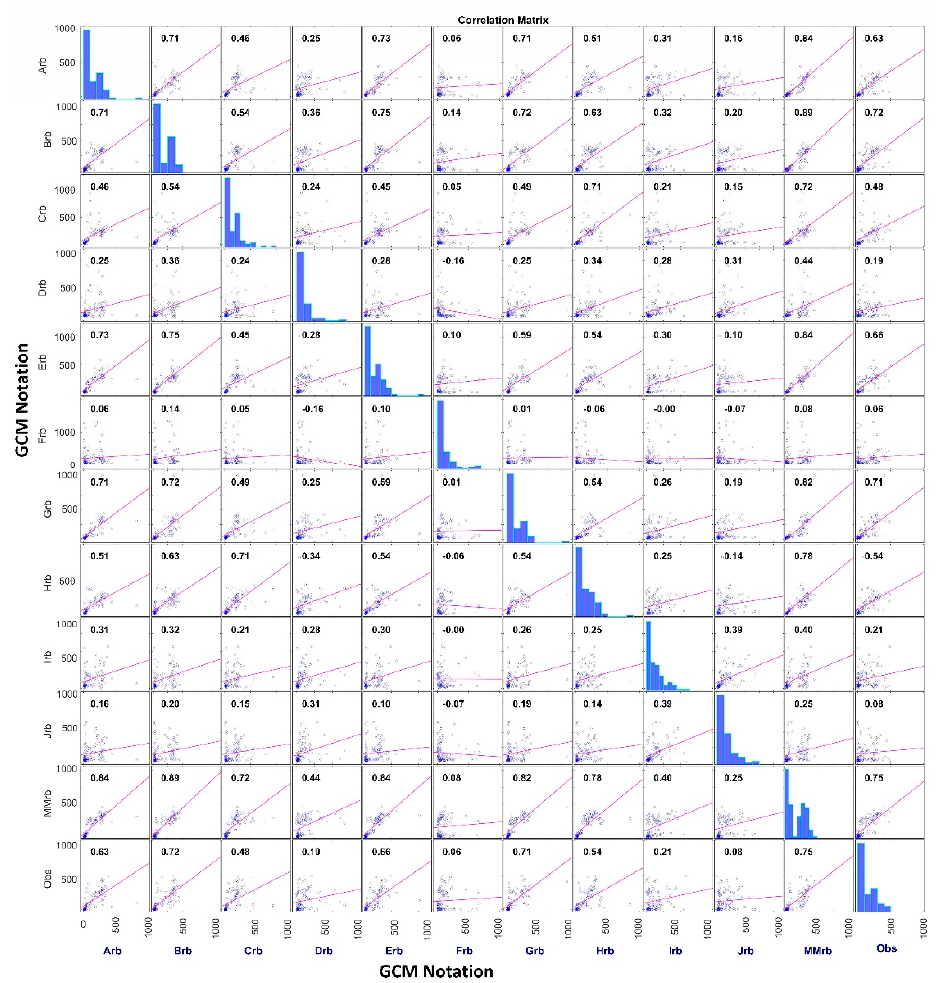
Figure 23. Correlation matrix of downscaled precipitation for different GCMs with the Re-Obs model for Zone 4. Notations are similar to Figure 17 except the GCM notations followed by the letter ‘b’ indicates corrected bias.